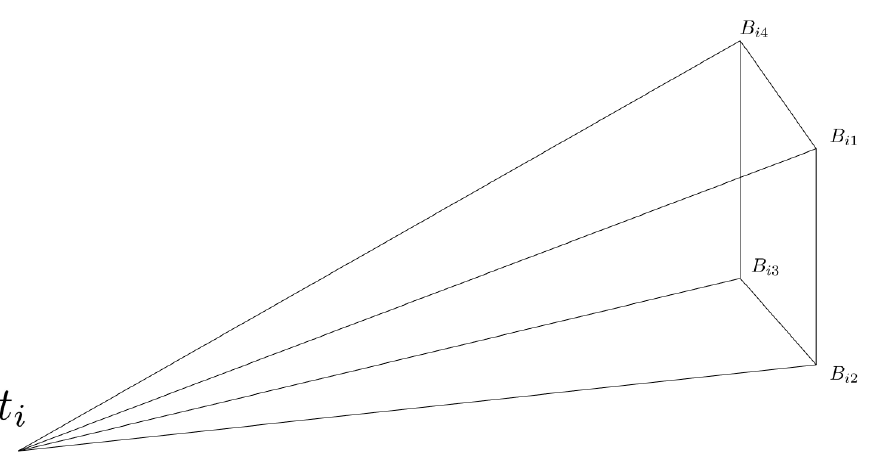
Figure 2. The camera viewing cone is defined by it’s four corner vectors ( B i j ) and the camera center ( t i ). The stitching plane coefficients [ ν , τ , ψ , η ] define the stitching plane with ν x + τ y + ψ z + η = 0 being the plane of stitching and λ ij determining the length of B ij when projected onto the stitching plane using ray-plane intersection as in Equation